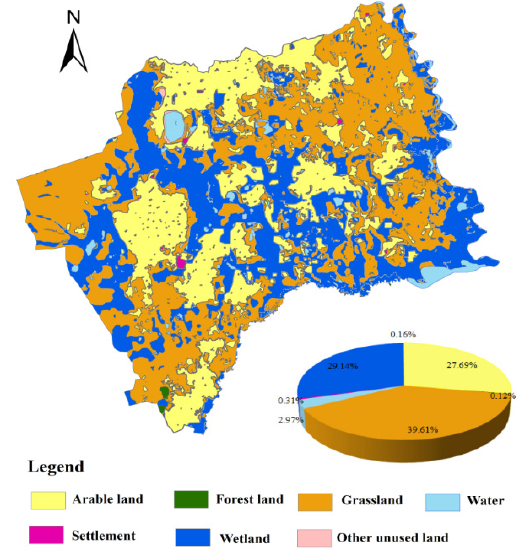
Figure 6. Land-use maps in the 1930s simulated by the spatial CA-Markov